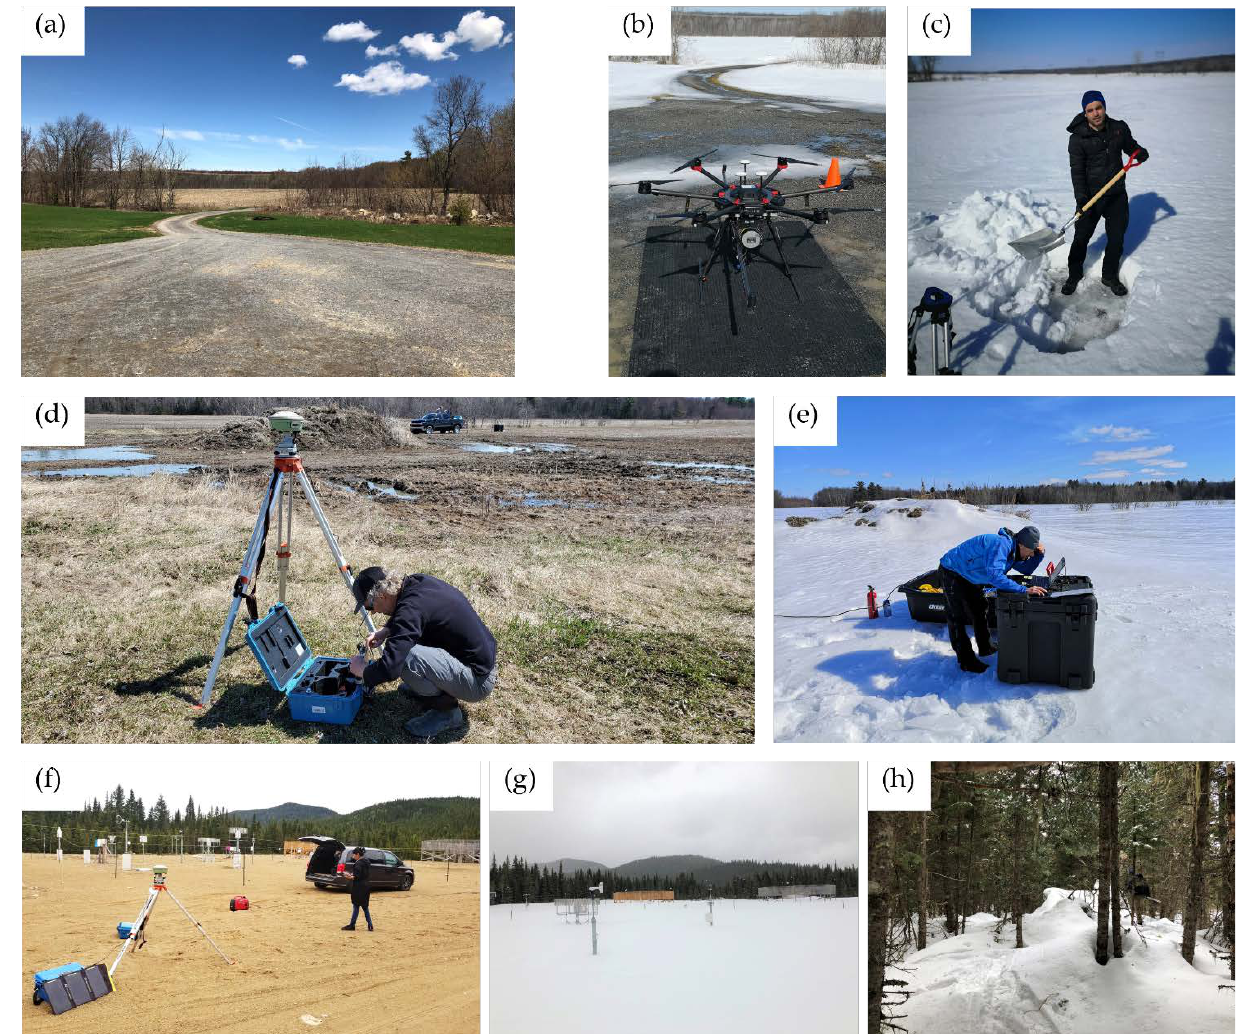
Figure 2. ( a ) Sainte-Marthe site during summer survey and ( b ) during winter survey; ( c ) presence